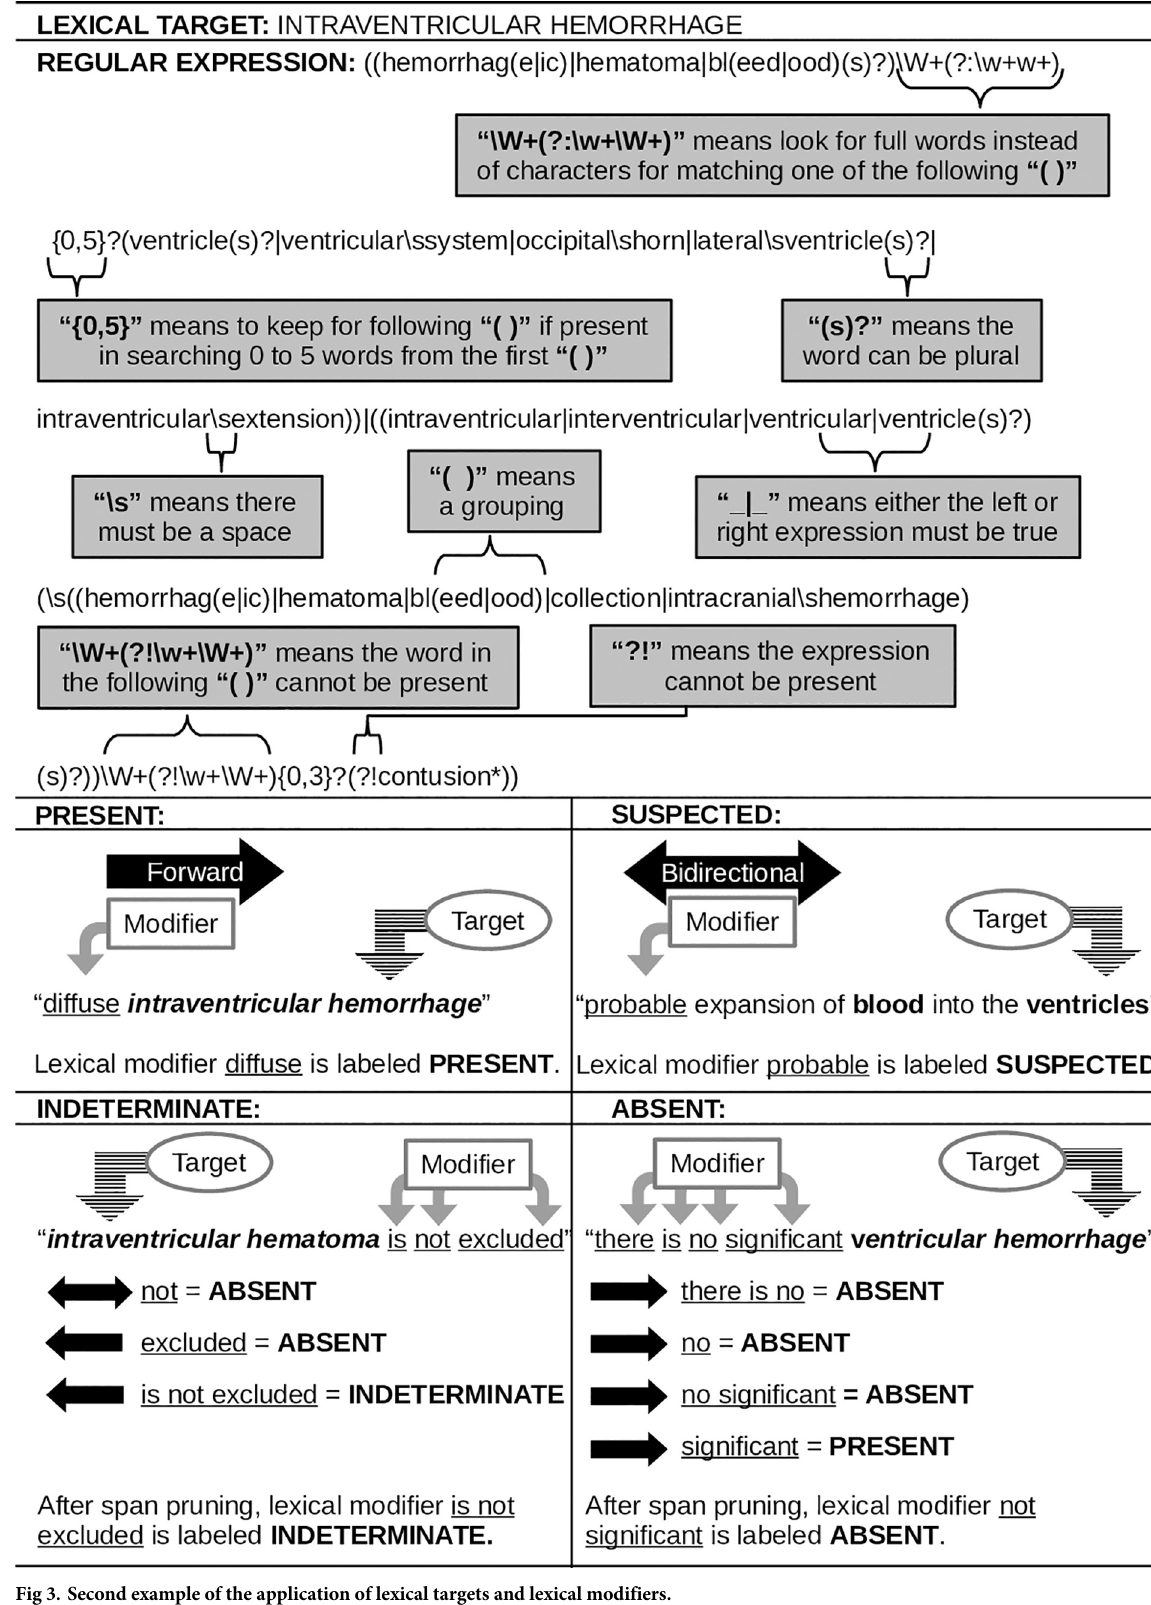
Fig 3. Second example of the application of lexical targets and lexical modifiers. https://doi.org/10.1371/journal.pone.0214775.g003 PLOS ONE | https://doi.org/10.1371/journal.pone.0214775 July 1,